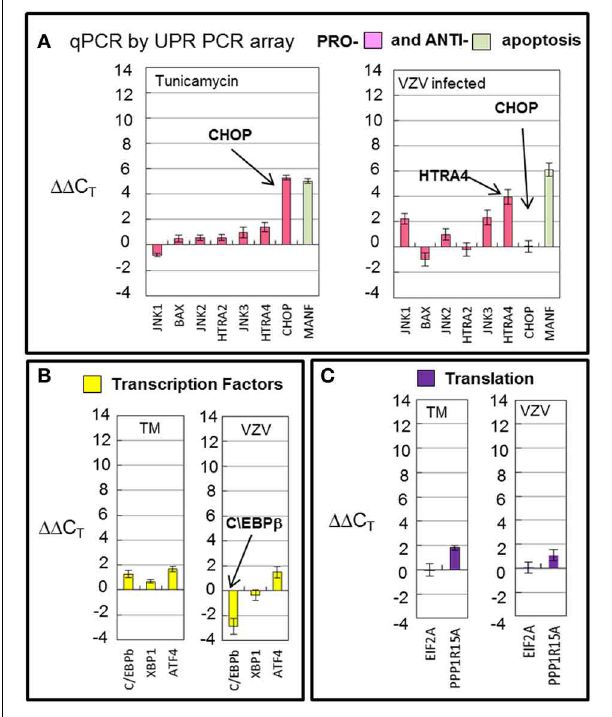
FIGURE 6 | VZV infection significantly upregulated the cholesterol synthesis associated transcript INSIG . Human fibroblast cells (MRC-5) were grown in tissue culture plates then infected with VZV-32 infected MRC-5 cells or treated with tunicamycin (TM), a N-glycosylation inhibitor. At 72 hpi, RNA was processed as described in the legend to Figure 2 . (A) Transcripts associated with lipid synthesis and metabolism where both VZV infected cells and tunicamycin cells showed similar transcription of RAMP4; VZV infected cells in particular showed more transcription of cholesterol synthesis regulator INSIG . (B) In order to assess two of the lipid transcript measurements by the UPR specific PCR array, RT-PCR was carried out on cDNA from uninfected, tunicamycin treated and VZV infected cells using primers to AMFR/gp78 and INSIG1.